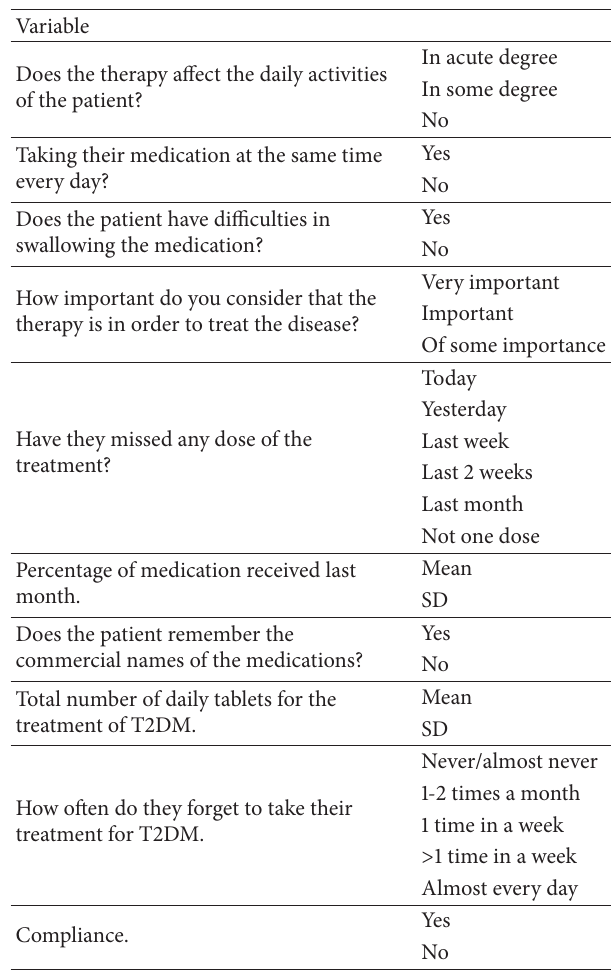
Table 1: Compliance